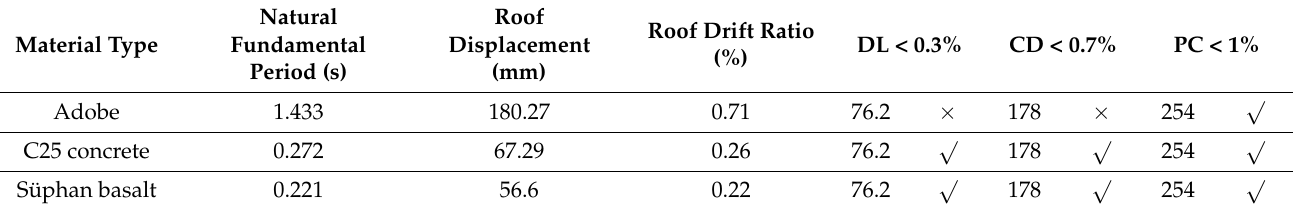
Table 15. Comparison of performance levels of three different material types (H = 25.40 m).